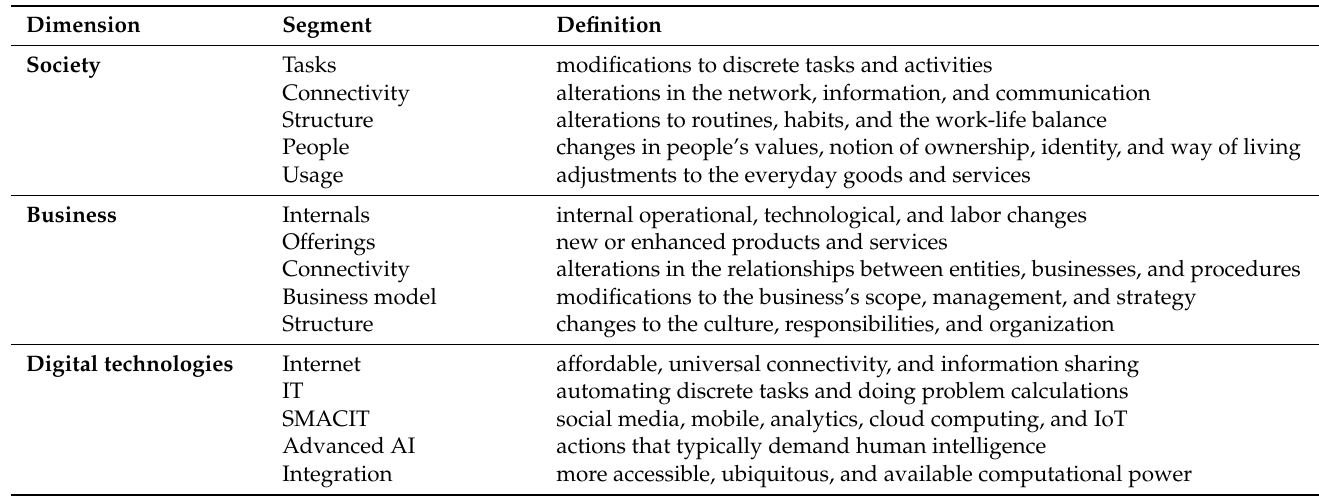
Table 3. Definition of essential components in conceptual